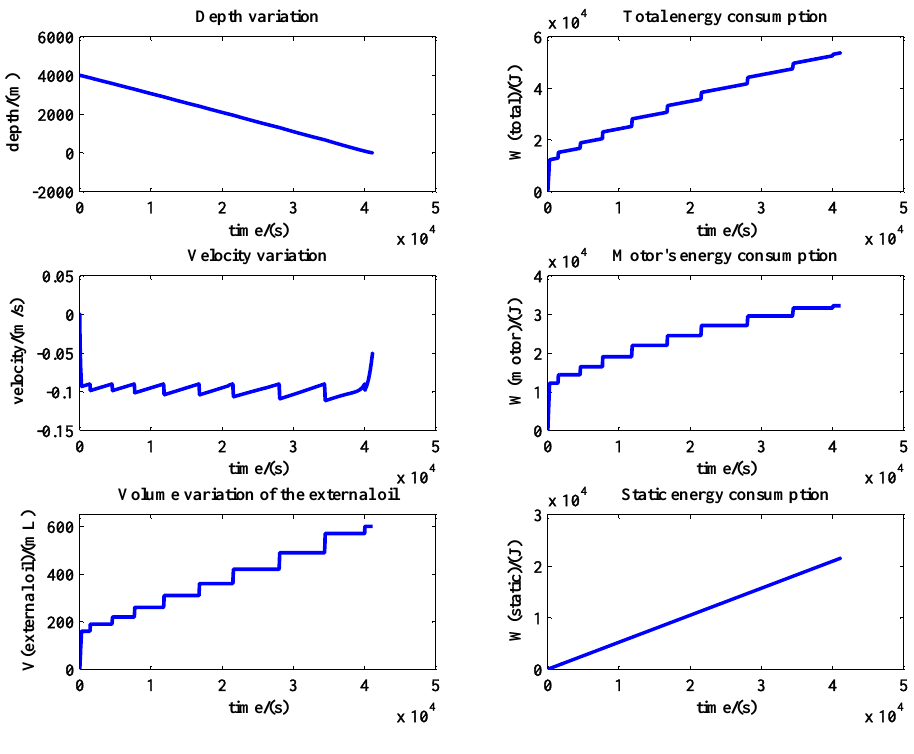
Figure 24. Parameters of the DSPB’s ascent stage optimized by the NSGA-II